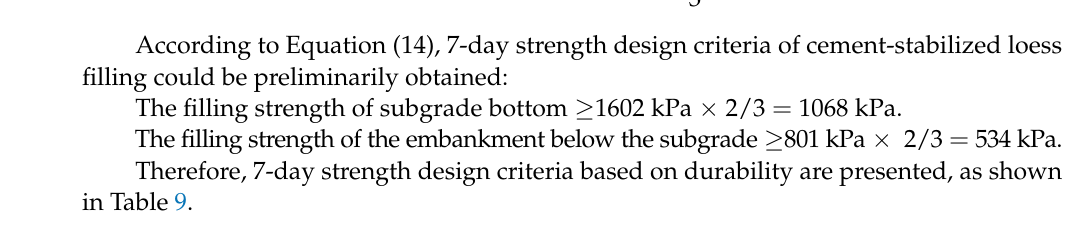
Table 9. The strength design criteria of cement-stabilized